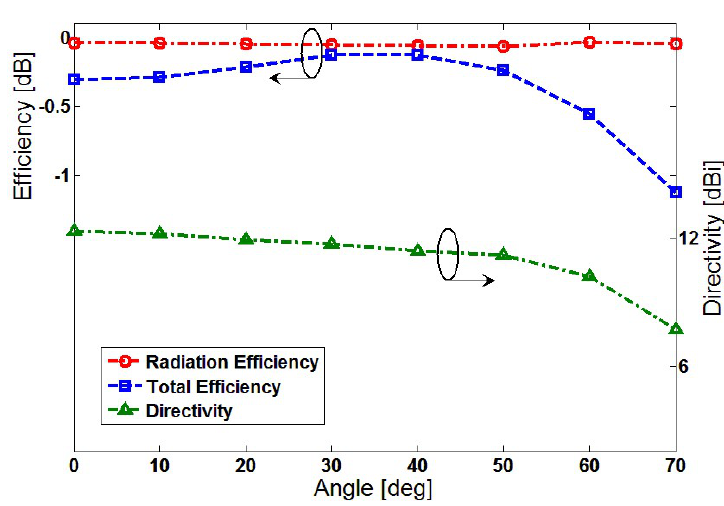
Figure 11. Simulated fundamental radiation parameters at 22.25 GHz.